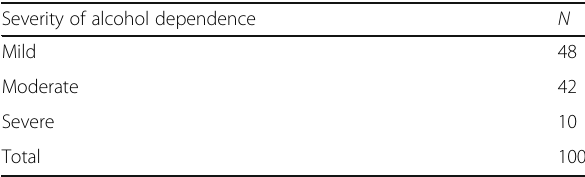
Table 2 Distribution among study population based on